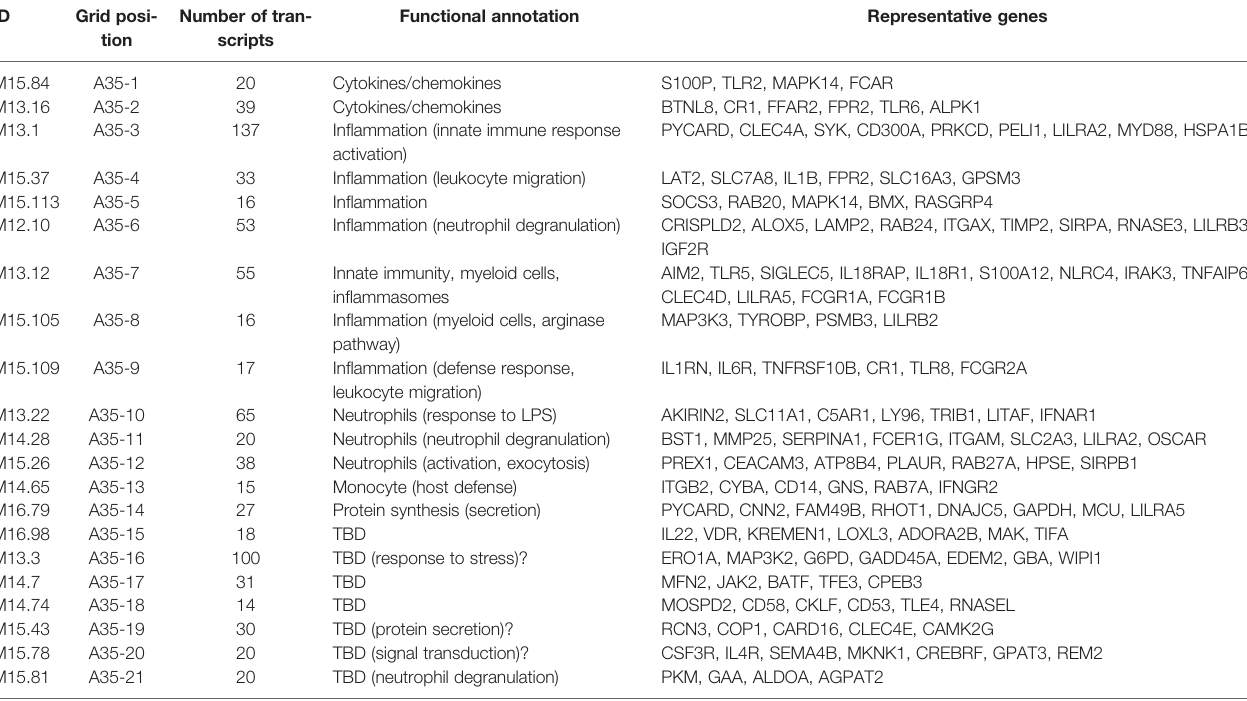
TABLE 2 | The 21 modules constituting aggregate